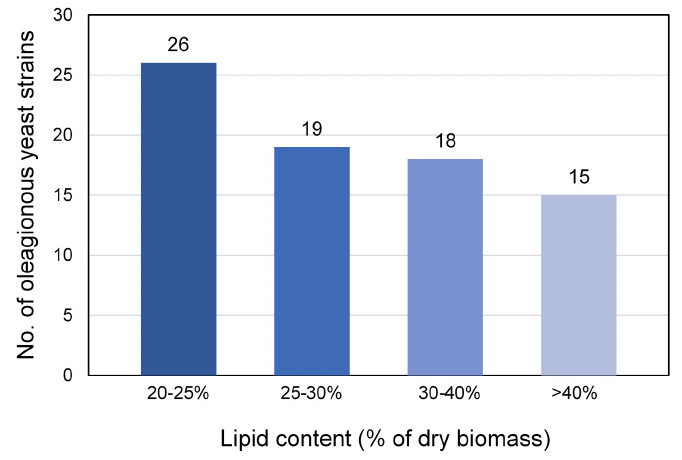
Figure 3. The number of oleaginous yeasts in this study. The lipid accumulation in the rage of 20–25% of dry biomass ( (cid:4) ), 25–30% of dry biomass ( (cid:4) ), 30–40% of dry biomass ( (cid:4) ) and >40% of dry biomass ( (cid:4) ). X-axis is the percentage of lipid content and Y-axis is number of yeast strains. Fifteen strains (19.2%) accumulated lipid content higher than 40% of dry biomass and belonged to Cyb. saturnus , L. mesembrius, L. starkeyi , L. tetrasporus , M. guilliermondii , P. flavescens ,